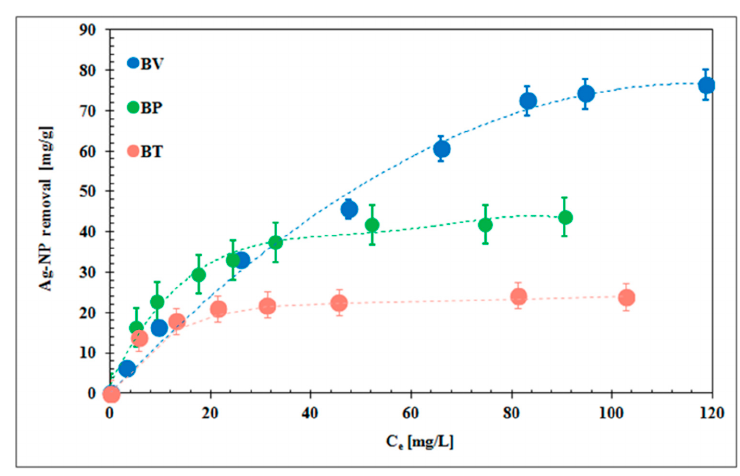
Figure 4. Freundlich adsorption isotherms of Ag-NPs on biochars. Table 3. Isotherms parameters of Ag-NP adsorption on biochars ( K F , K L , 1/ n : constants; Q m : maximum amount of adsorbate in the monomolecular layer).